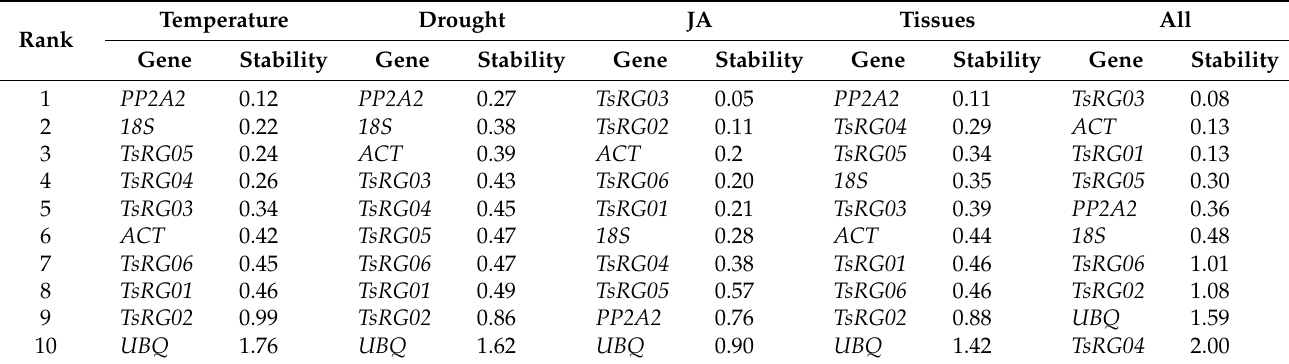
Table 2. Stability of candidate RGs calculated by NormFinder under different conditions.